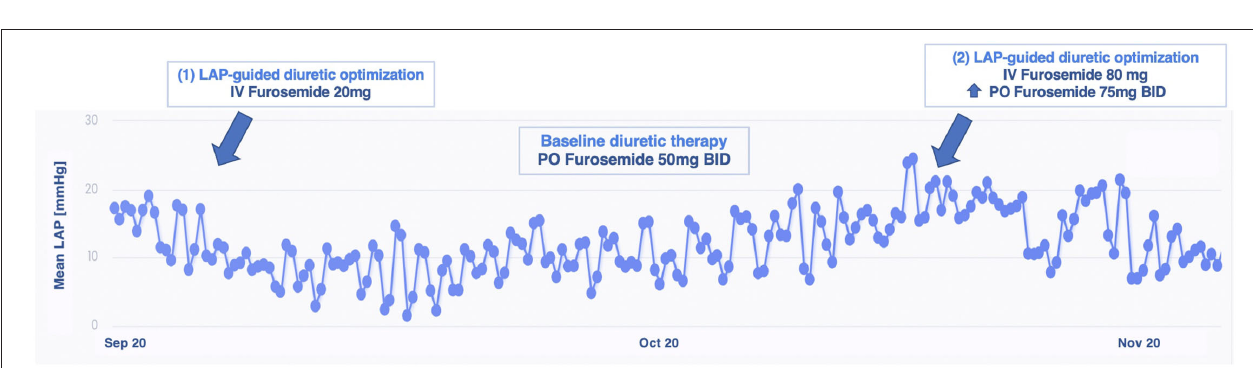
FIGURE 4 | Left atrial pressure-guided IV diuretic administration managed to reduce LAP over time in patient 3. BID, bis in die; IV, intravenous; LAP, left atrial pressure; PO, per